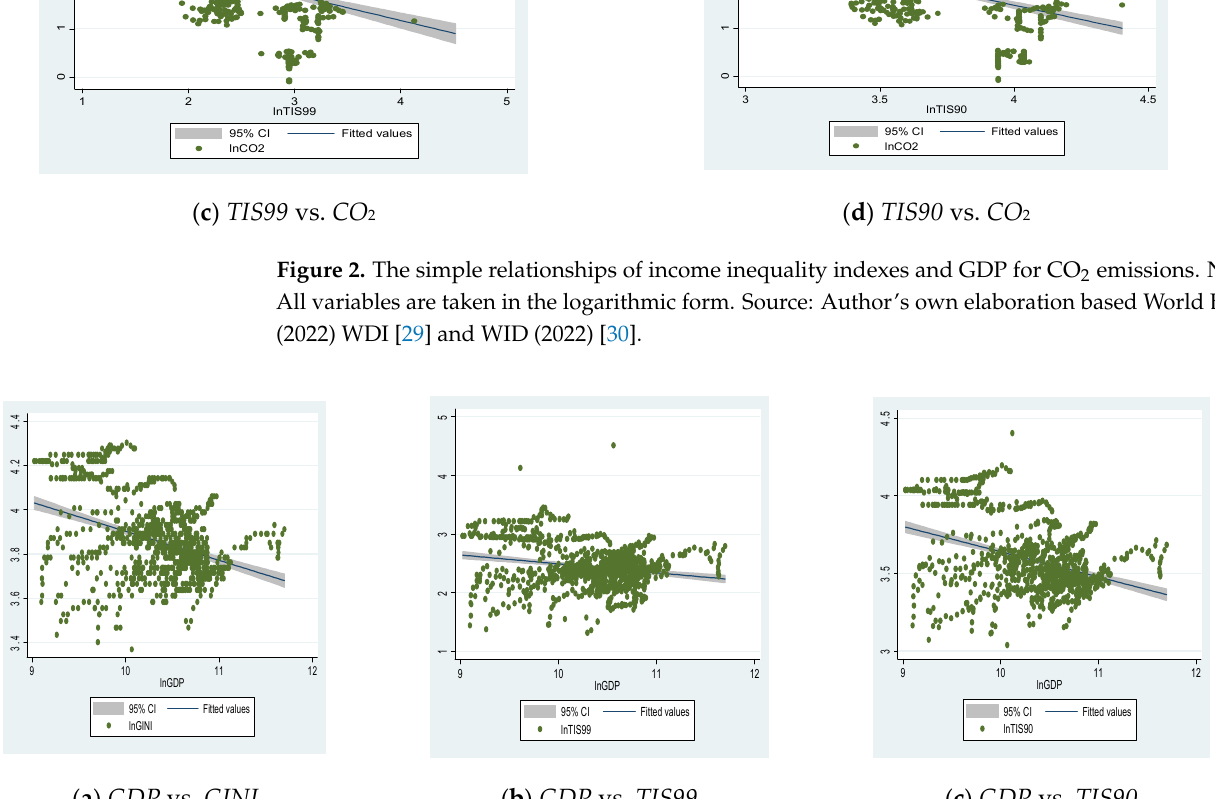
Figure 3. The simple relationships of income inequality indexes and GDP. Note: All variables are taken in the logarithmic form. Source: Author’s own elaboration based World Bank (2022) WDI [29] and WID (2022) [30].